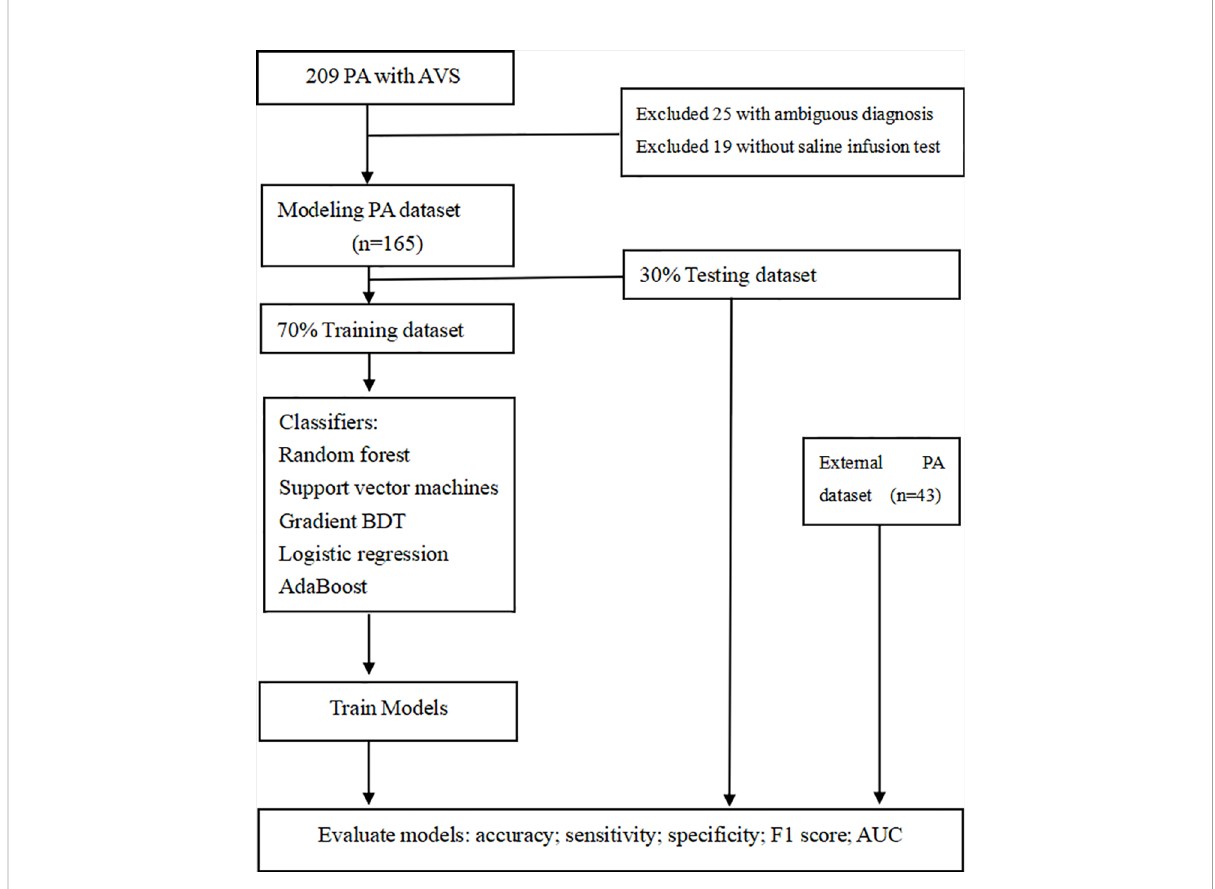
FIGURE 1 The work fl ow for developing machine learning-based models in this